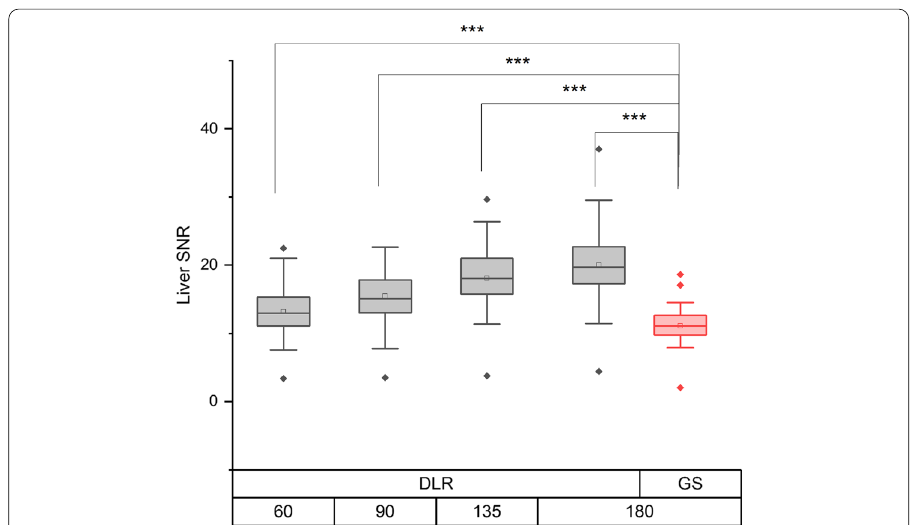
Fig. 8 Comparison of the liver SNR between DLR groups and the referenceGS_180 group. All DLR groups show a significantly improved liver SNR compared to the reference group, indicating reduced image noise. *** p < 0.001. SNR, signal-to-noise ratio